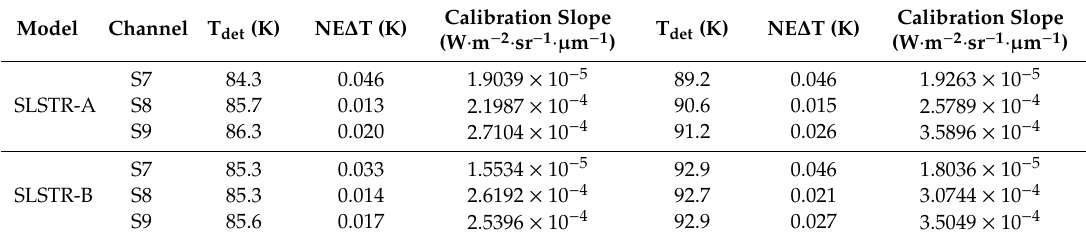
Table 6. NEDTs in K and calibration slope in W · m − 2 · sr − 1 · µ m − 1 per count for scene temperature at ~270 K for nominal operating temperature and the elevated temperature. Detector temperatures are shown separately for each